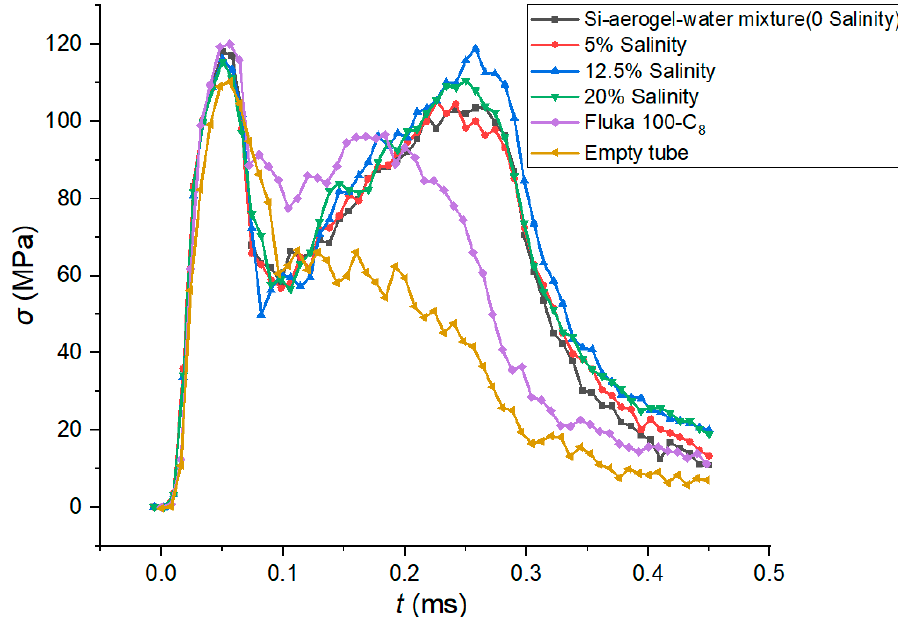
Figure 11. Stress–time curves with different salinities.